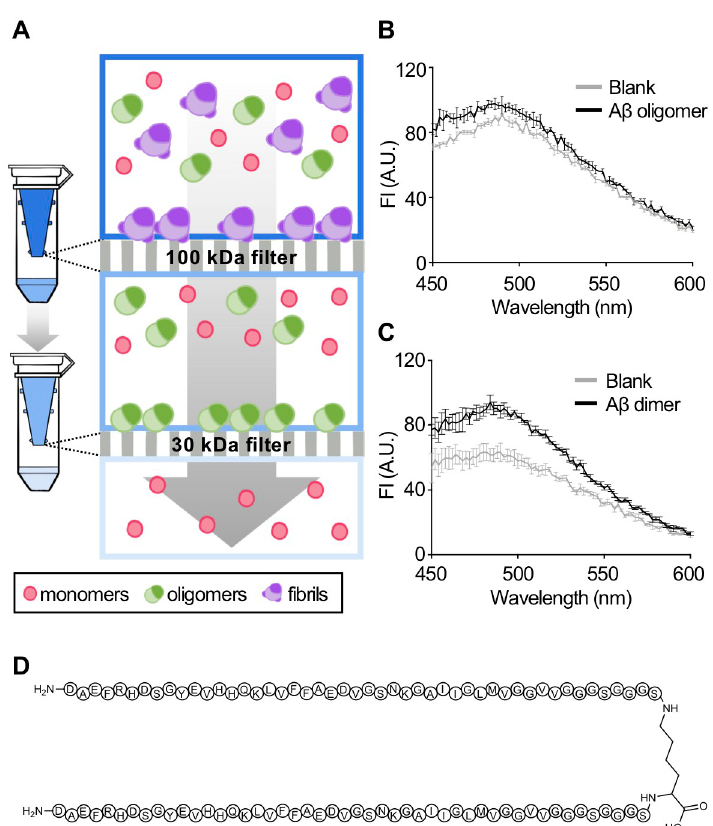
Fig 5. In vitro analysis of fluorescent YI-13 to detect its interaction with A β oligomers and dimers. (A) A scheme of isolating oligomers from heterogeneous mixture of A β aggregates (50 μ M). Through 100 kDa membrane filter, high molecular weight A β oligomers over 100 kDa were removed from the mixture of A β aggregates. The filtrate sample was applied to the 30 kDa filter to exclude low molecular weight A β aggregates. Only A β oligomers sized from 30 to 100 kDa were used for further experiment. The illustration was drawn using Adobe Photoshop software. (B-C) Fluorescence spectral scan of YI-13 (250 μ M) when applied to A β . Blank indicates fluorescent intensities of YI-13 without A β . (B) Fluorescent analyses of YI-13 with the isolated A β oligomers. (C) Fluorescent analyses of YI-13 with the parallel A β dimer (25 μ M). (D) Structure of synthesized parallel A β dimer with a lysine linker and spacer sequences, (GGGS) 2 . Abbreviations: FI = fluorescence intensity, AU = arbitrary unit.